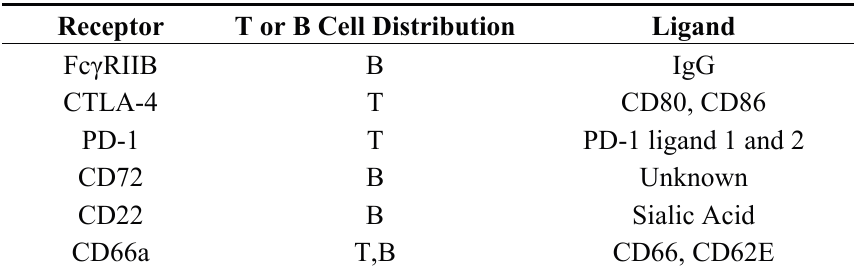
Table 1. Representative immunoreceptor tyrosine-based inhibitory motif (ITIM) receptors expressed on T and B